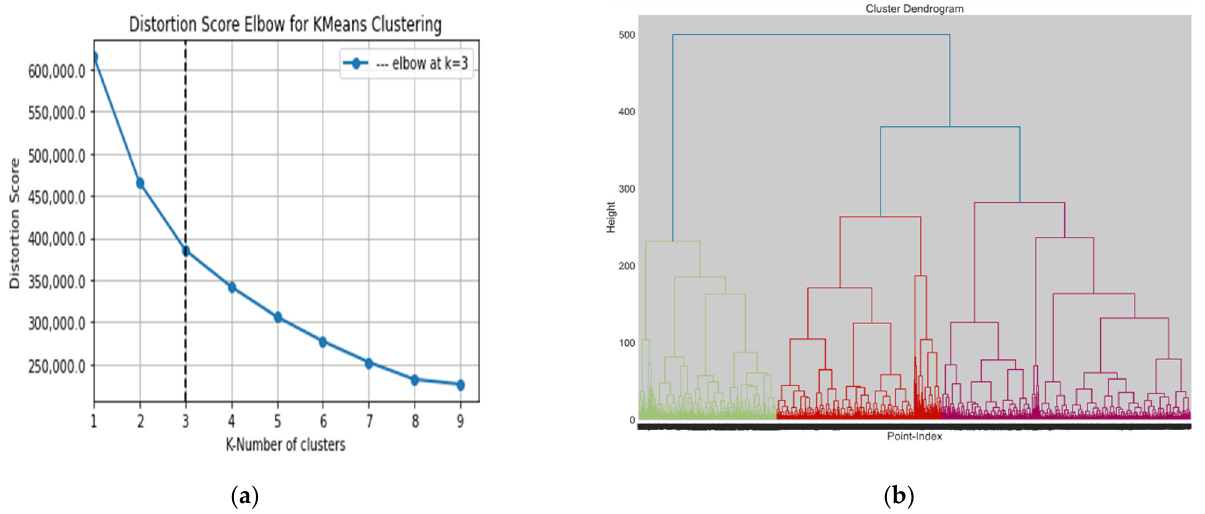
Figure 4. The optimal number of clusters for the first investigation object: the elbow method ( a ) shows that the optimal number of clusters is equal to 3, while on the dendrogram ( b ), the possibility of the optimal number of clusters is also equal to 3.